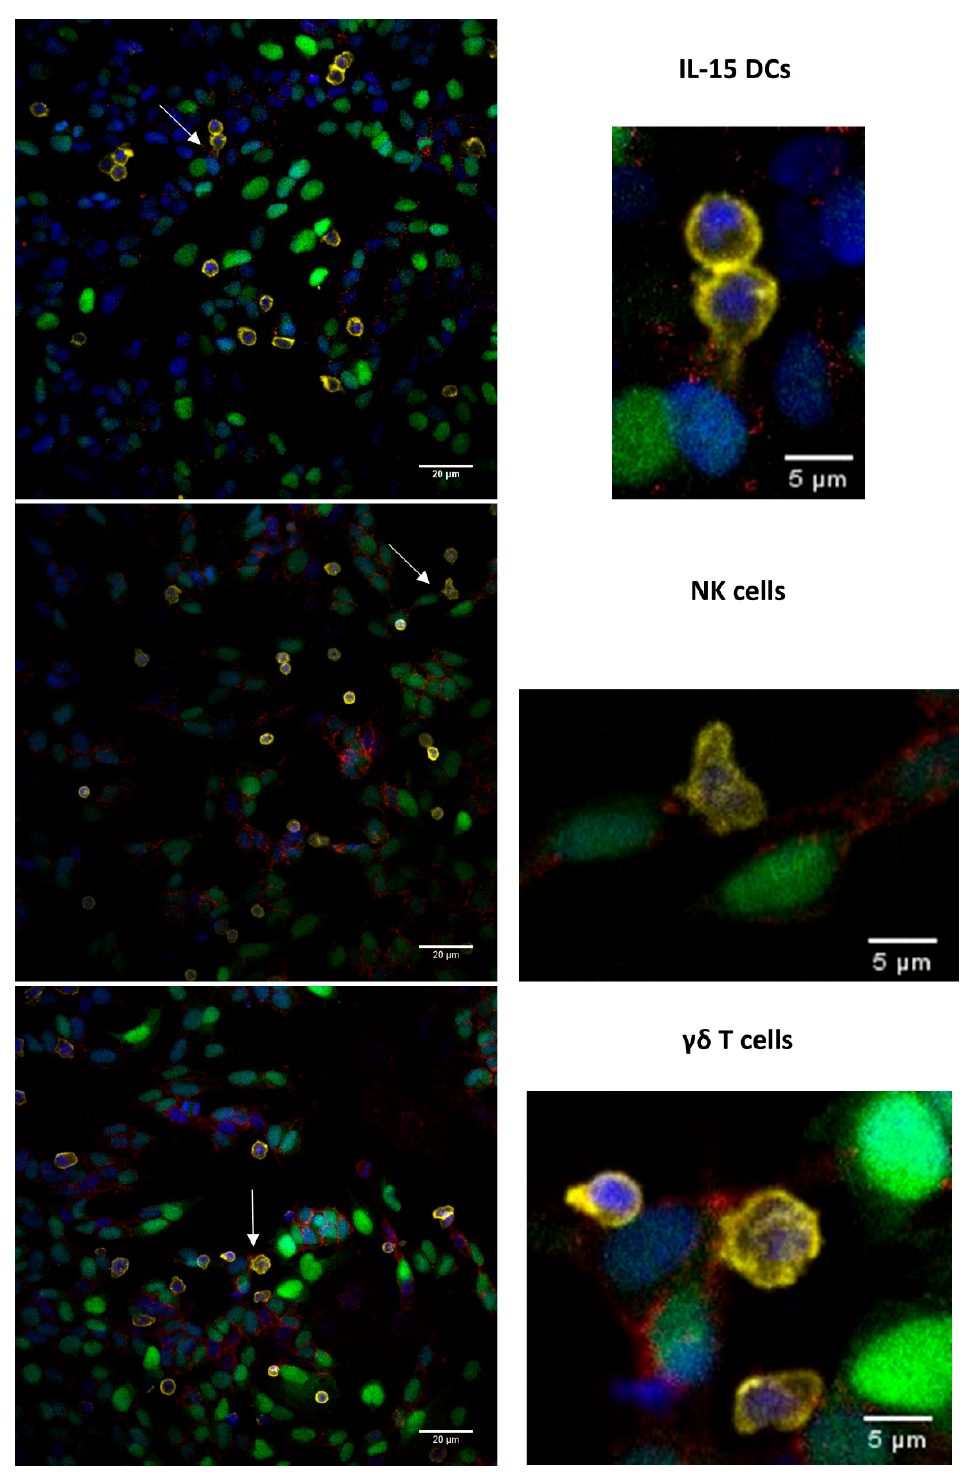
Figure 5. Association of Cluster of differentiation (CD)56–CD56 interactions and the “kiss of death”—cytotoxic immunological synapse between immune cells and cancer cells. SH-SY5Y-eGFP cells (green) were co-cultured with immune effector cells (CD45; yellow), namely, interleukin (IL)-15 dendritic cells (DCs) (upper row, n = 3), natural killer cells (middle row, n = 3) or γδ T cells (bottom row, n = 3), and mounted with 4 ′ ,6-diamidino-2-phenylindole (DAPI) (blue). White arrows on the left overview images indicate a probable interface between immune cells and cancer cells (enlarged in the right column). The connection between both cell types is associated with an accumulation of red signal, being CD56 homodimerization. Scale bar: left column = 20 µm, right column = 5 µm.